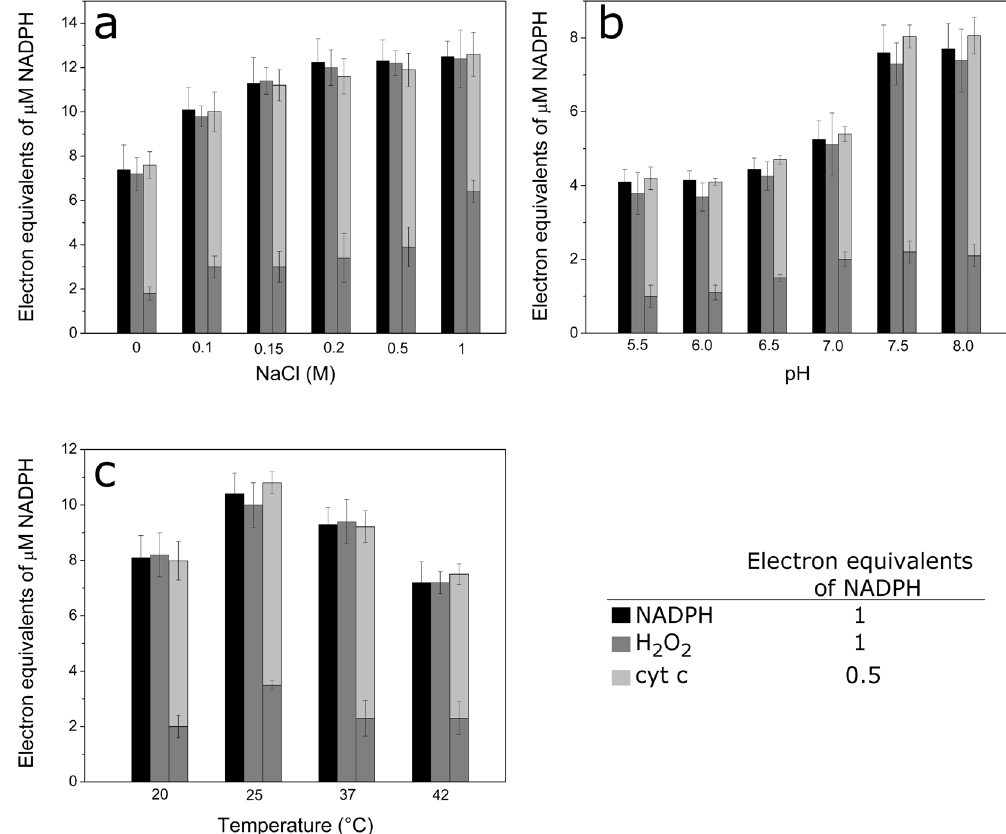
Figure 2. Uncoupling of Ct CPR under different conditions. Bars represent NADPH consumed (black), H 2 O 2 produced (grey) and cytochrome c reduced (light grey). ( a ) Effect of ionic strength on the uncoupling was performed at different concentrations of NaCl (0–1 M). ( b ) The effect of pH was analysed using 30 mM sodium phosphate buffer (pH 5.5–8.0). ( c ) To analyse the effect of temperature on uncoupling, reactions were carried out at different temperatures (20–42